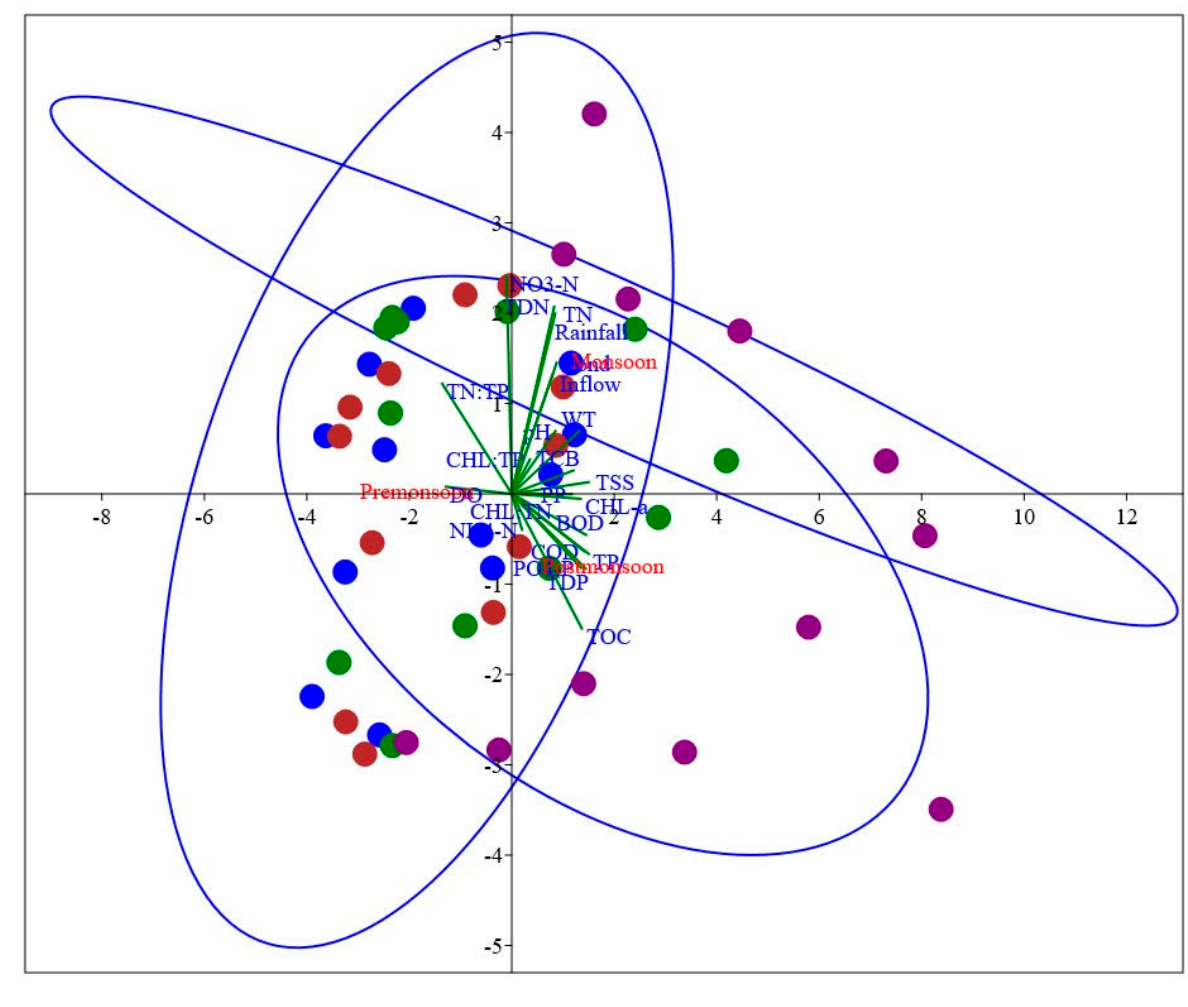
Figure 6. Biplot on the first two principal components (color meaning: blue–site 1, brown–site 2, green–site 3, purple–site 4).